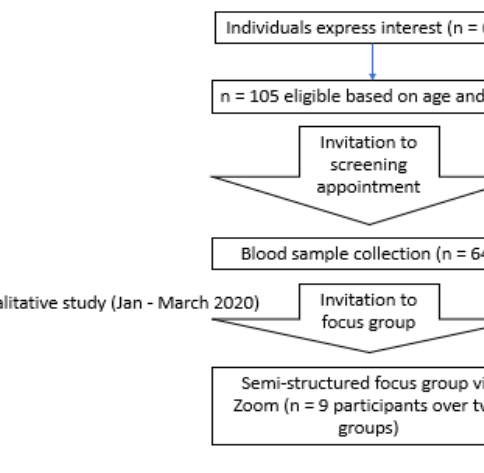
Figure 1. Flow diagram of the mixed-methods SWAT for the GetGutsy trial.